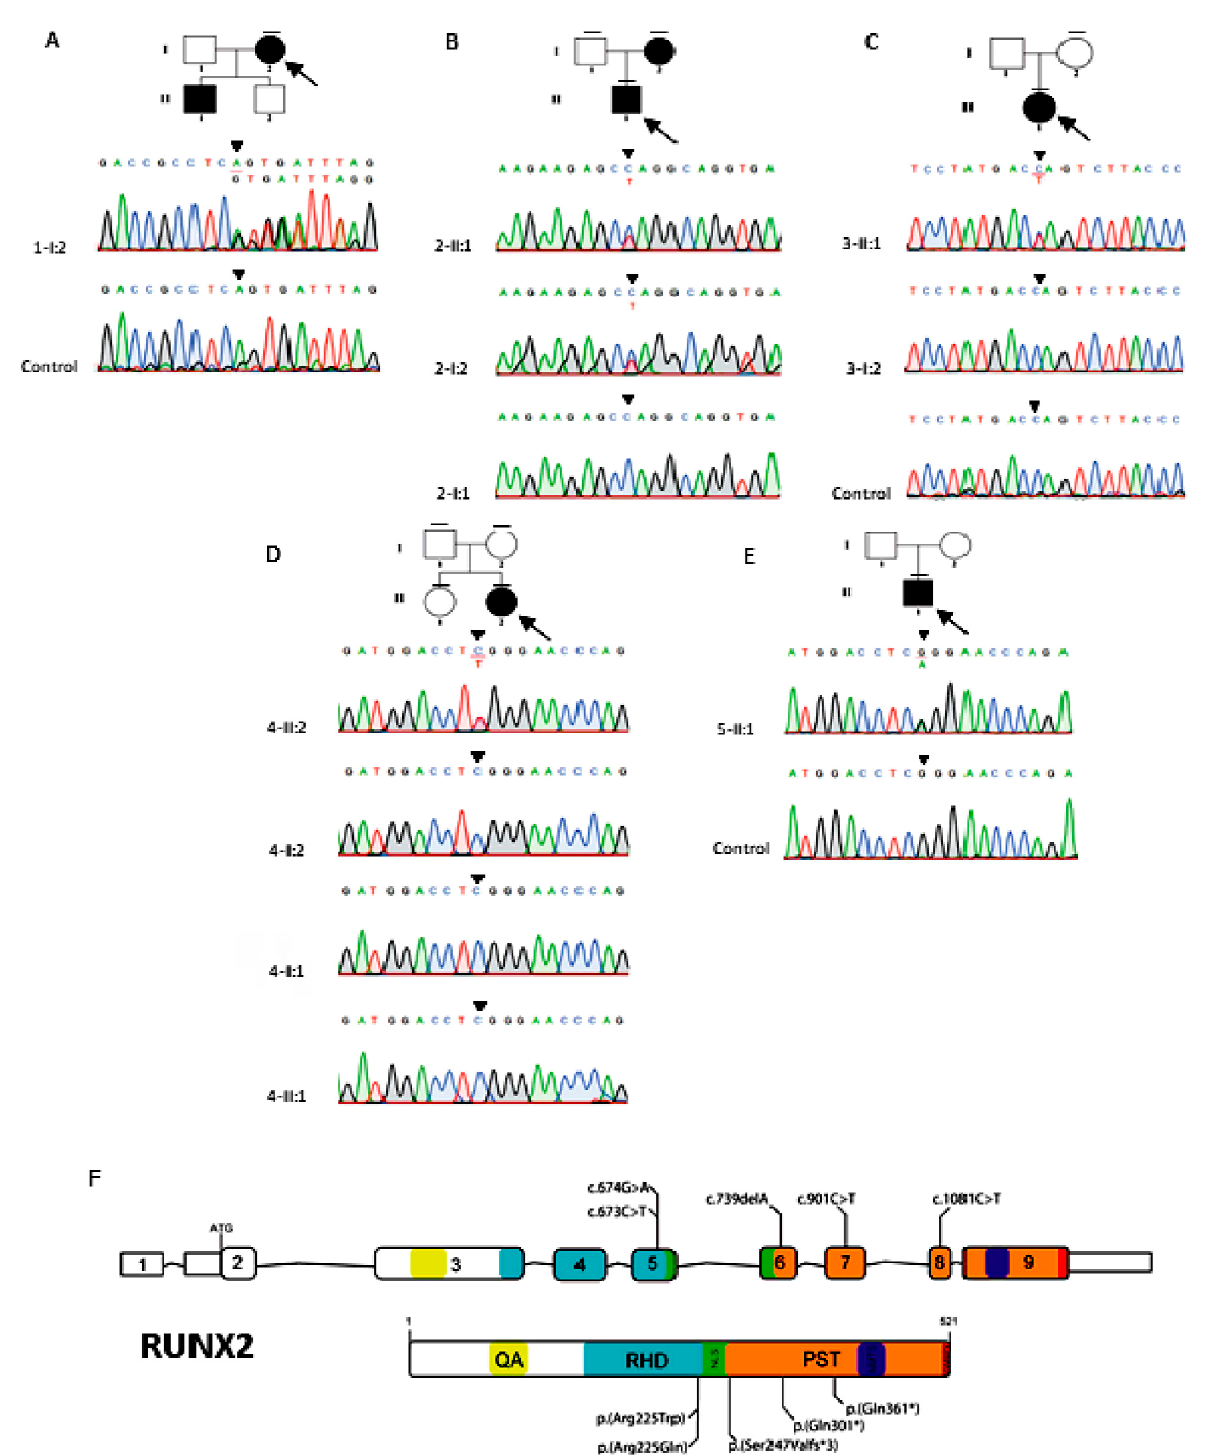
Figure 3- Pedigrees and genetic variants of Family 1-5. (A) 1-I:2 possesses the frameshift variant, c.739delA (p.(Ser247Valfs*3)), in RUNX2. (B) 2-II:1 and 2-I:2 possesses the nonsense variant, c.901C>T (p.(Gln301*)), in RUNX2. The variant was not identified in 2-I:1. (C) 3-II:1 has the nonsense variant, c.1081C>T (p.(Gln361*)), in RUNX2. (D) 4-II:2 has the missense variant, c.673C>T (p.(Arg225Trp)), in RUNX2. 4-I:1, 4-I:2 and 4-II:1 did not have the variants. (E) 5-II:1 possesses the missense variant, c.674G>A (p.(Arg225Gln)) in RUNX2. The arrow indicates the proband. The dash above each symbol indicates the subject with genetic test. (F) Schematic diagrams of RUNX2 gene and protein showed the locations of RUNX2 variants identified in this study. QA, poly-glutamine and poly-alanine repeat region; RHD, runt homologous domain; NLS, nuclear localization signal; PST, proline-serine-threonine-rich region; NMST, nuclear matrix targeting sequence; VWRPY, pentapeptide